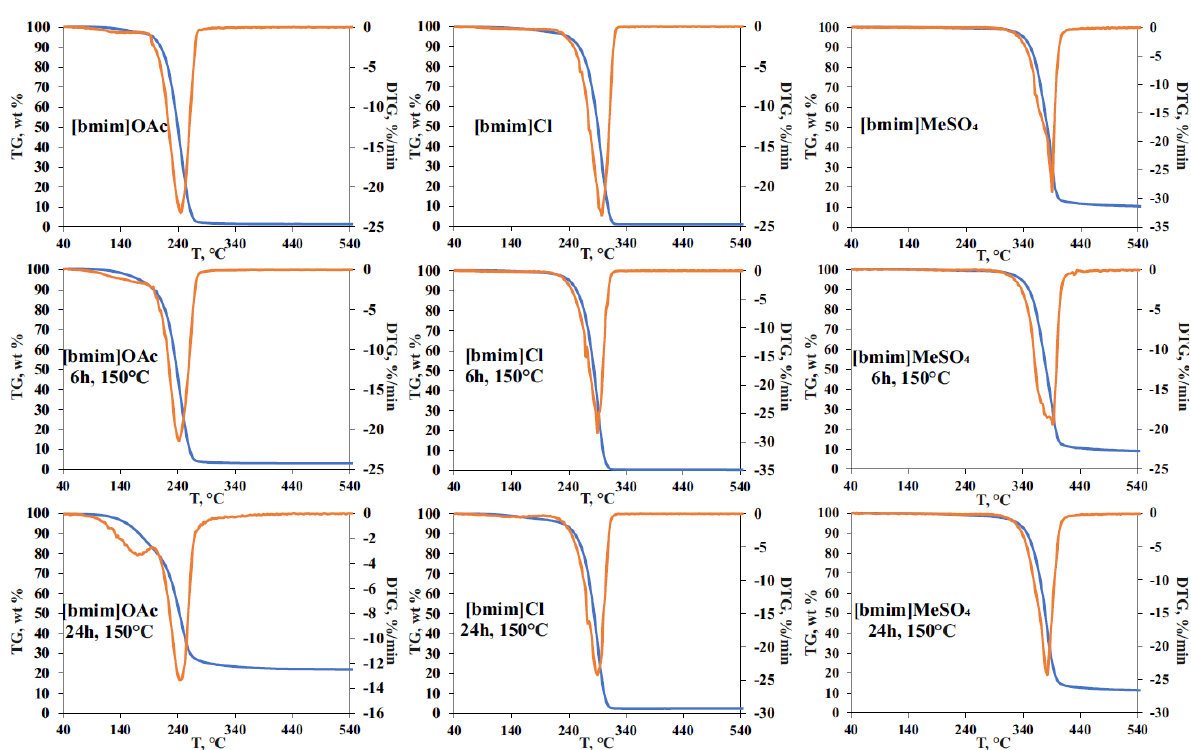
Figure 4. TG curves for initial and thermally treated at 150 °C for 6- and 24-h IL samples.